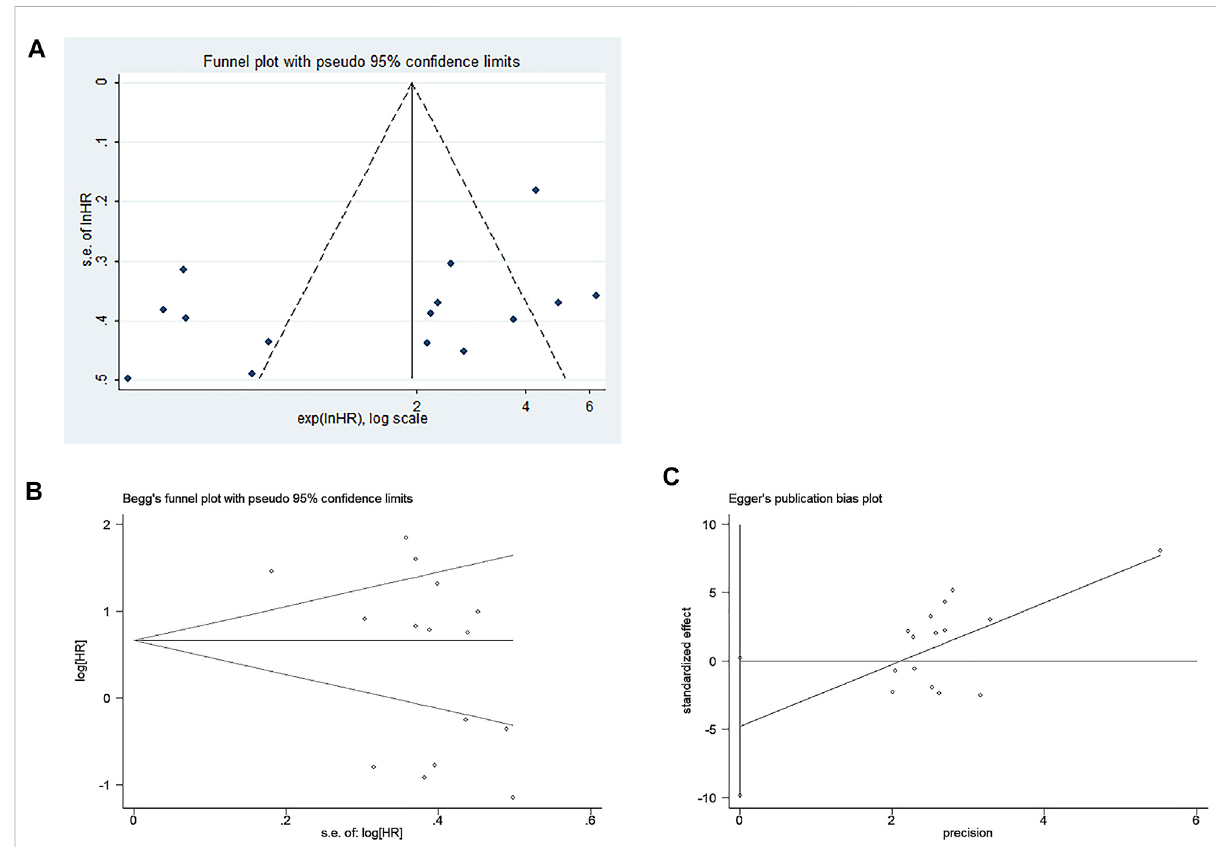
FIGURE 10 Publication bias of included studies for the prognostic meta-analysis. (A) Funnel plot; (B) Begg ’ s test; (C) Egger ’ s